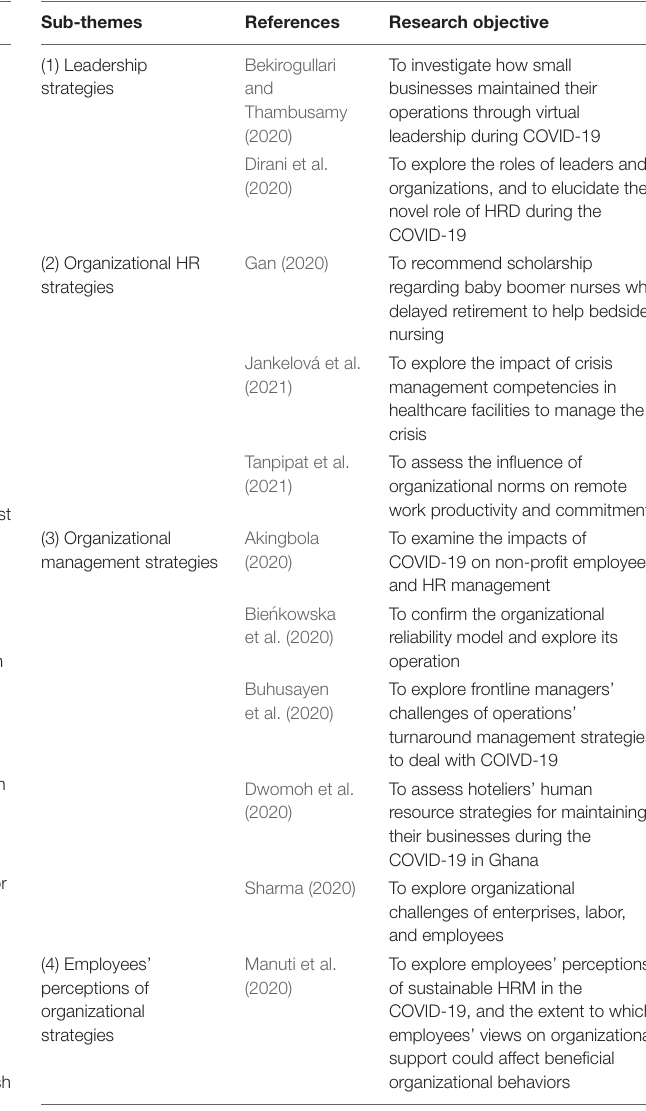
TABLE 4 | Articles on employee wellbeing. TABLE 5 | Articles on organizational